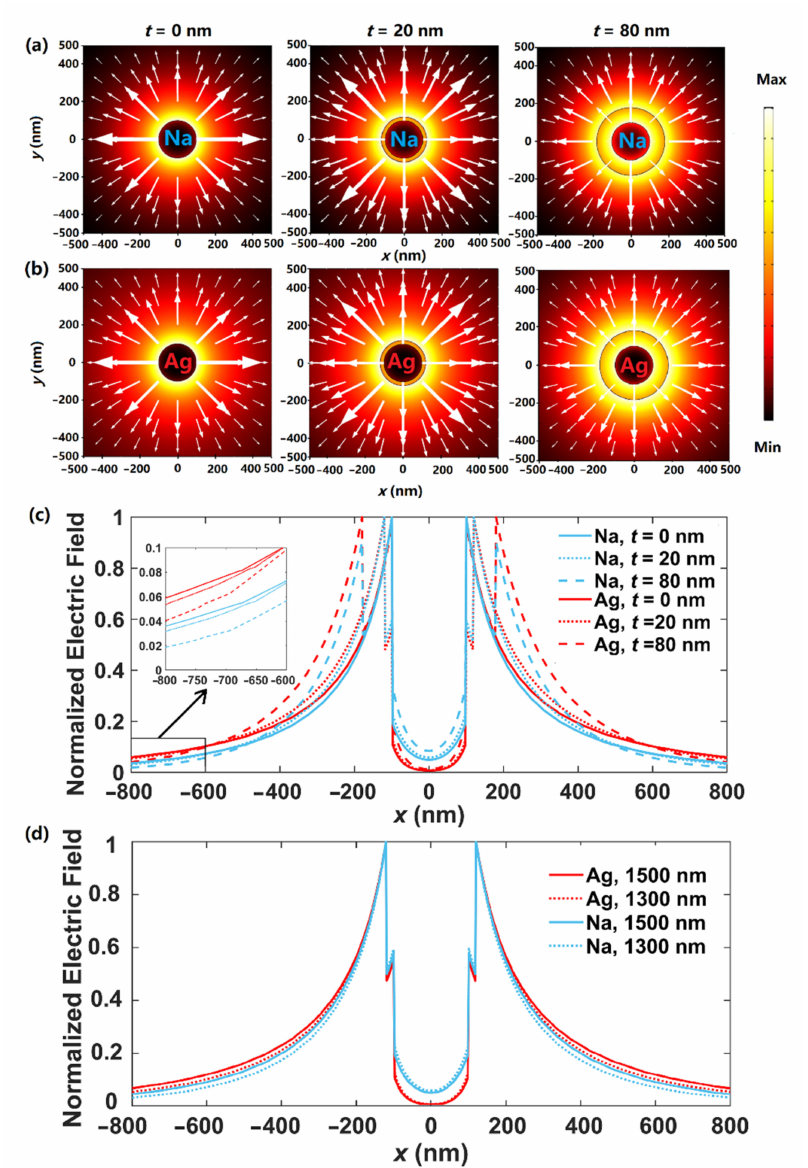
Figure 3. Field distributions of | E | of the fundamental mode at λ = 1300 nm for dielectric-coated ( a ) Na and ( b ) Ag nanowires at t = 0, 20, 80 nm. White arrows indicate radially polarized electric fields. ( c ) Field distributions along x -direction. ( d ) Comparison of field distributions along x -direction for λ = 1300 and 1500 nm with t = 20